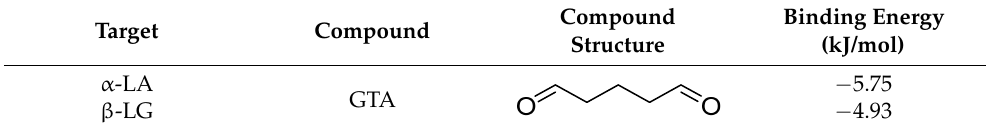
Table 3. Target protein docking results.